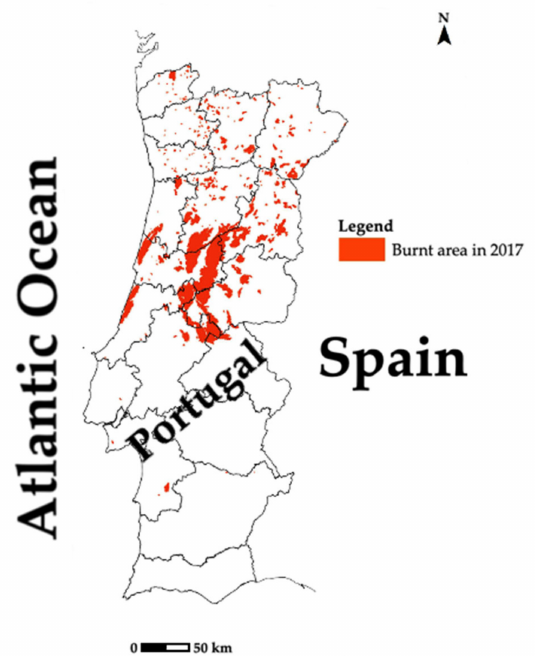
Figure 1. Location of burnt areas in mainland Portugal in 2017 (Source: GNR—Guarda Nacional Republicana, Forestry Technical O ffi ces, Landsat and Copernicus, obtained through the website of ICNF—Institute for Nature Conservation, available at